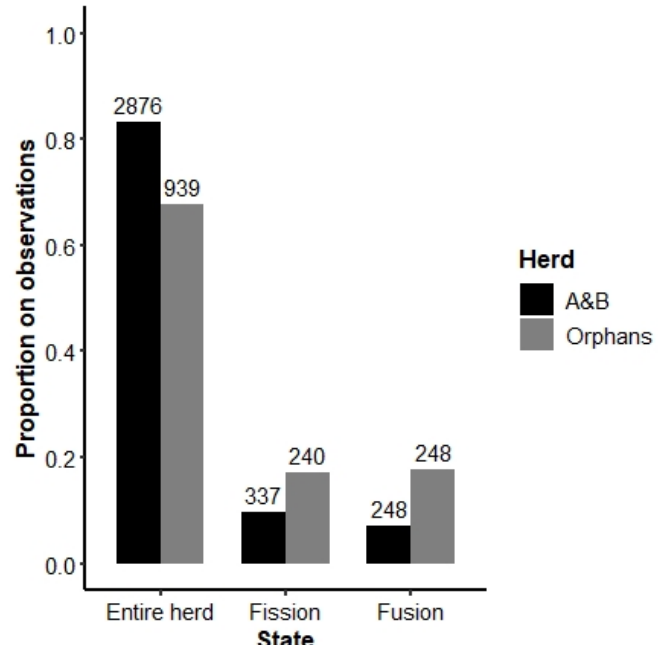
Figure 4. Fission–fusion dynamics of the A&B herd and the Orphans. “Entire herd” refers to observations in which all members of either the A&B or Orphans herd were present. “Fission” indicates instances in which only a subsection of either the A&B herd or Orphans were observed. “Fusion” refers to instances in which all or some members of both the A&B herd and Orphans were present. Numbers on top of the bars indicate the number of scans included in each category.